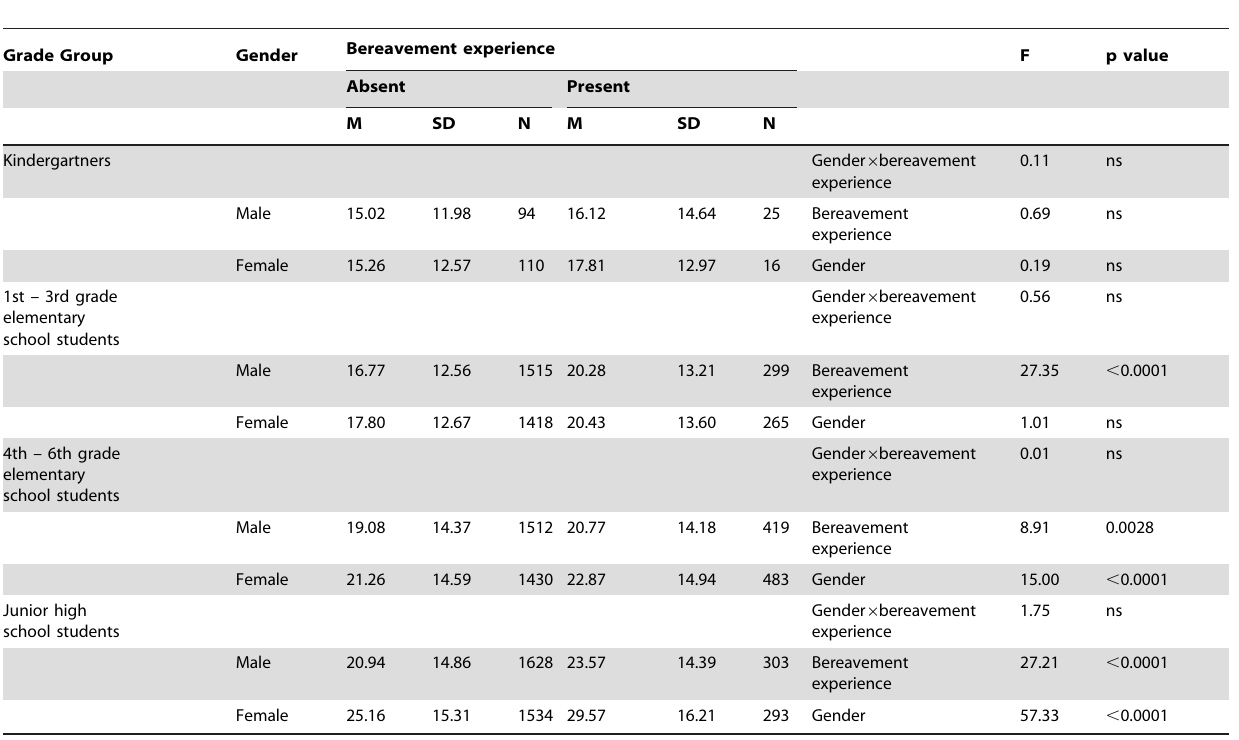
Table 5. Average PTSSC-15 score (grade & gender & bereavement experience).